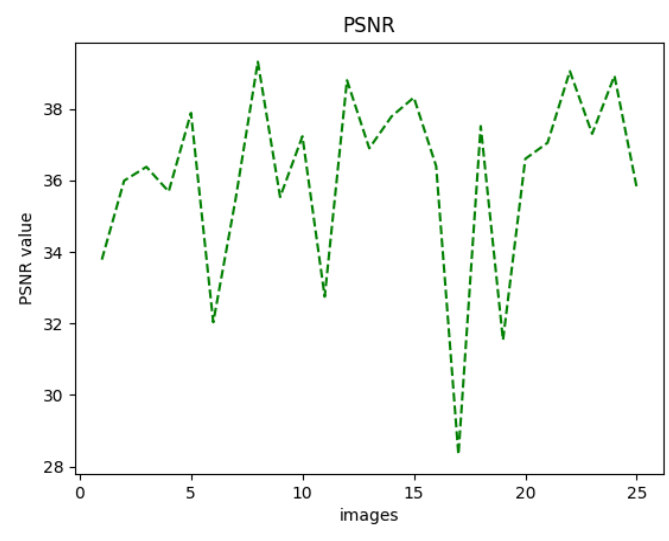
Figure 13. Test images (25) PSNR of